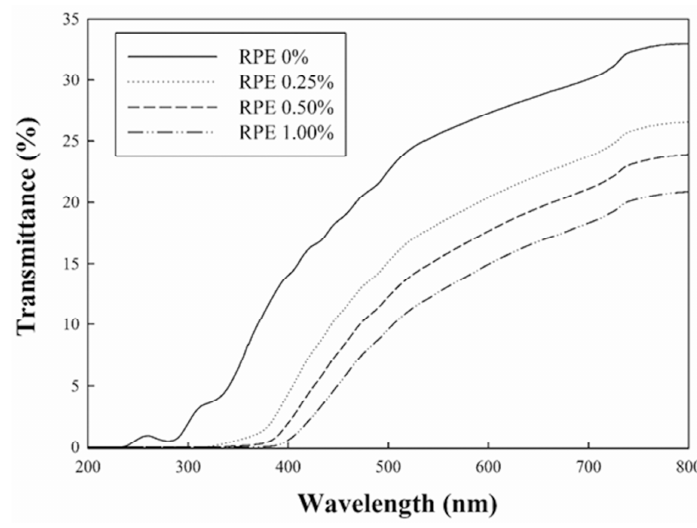
ff erent concentrations of